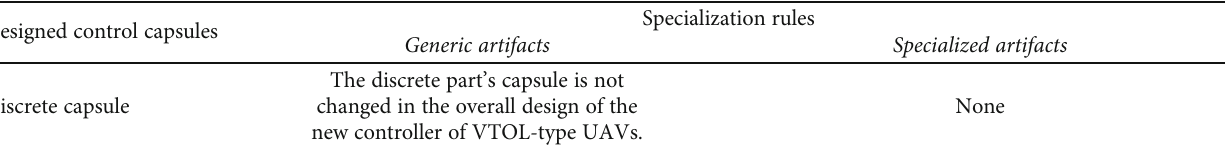
Table 2: The main control capsules of PIM can be customized and reused in the new control application for various UAVs of the Vertical Take-O ff and Landing (VTOL)